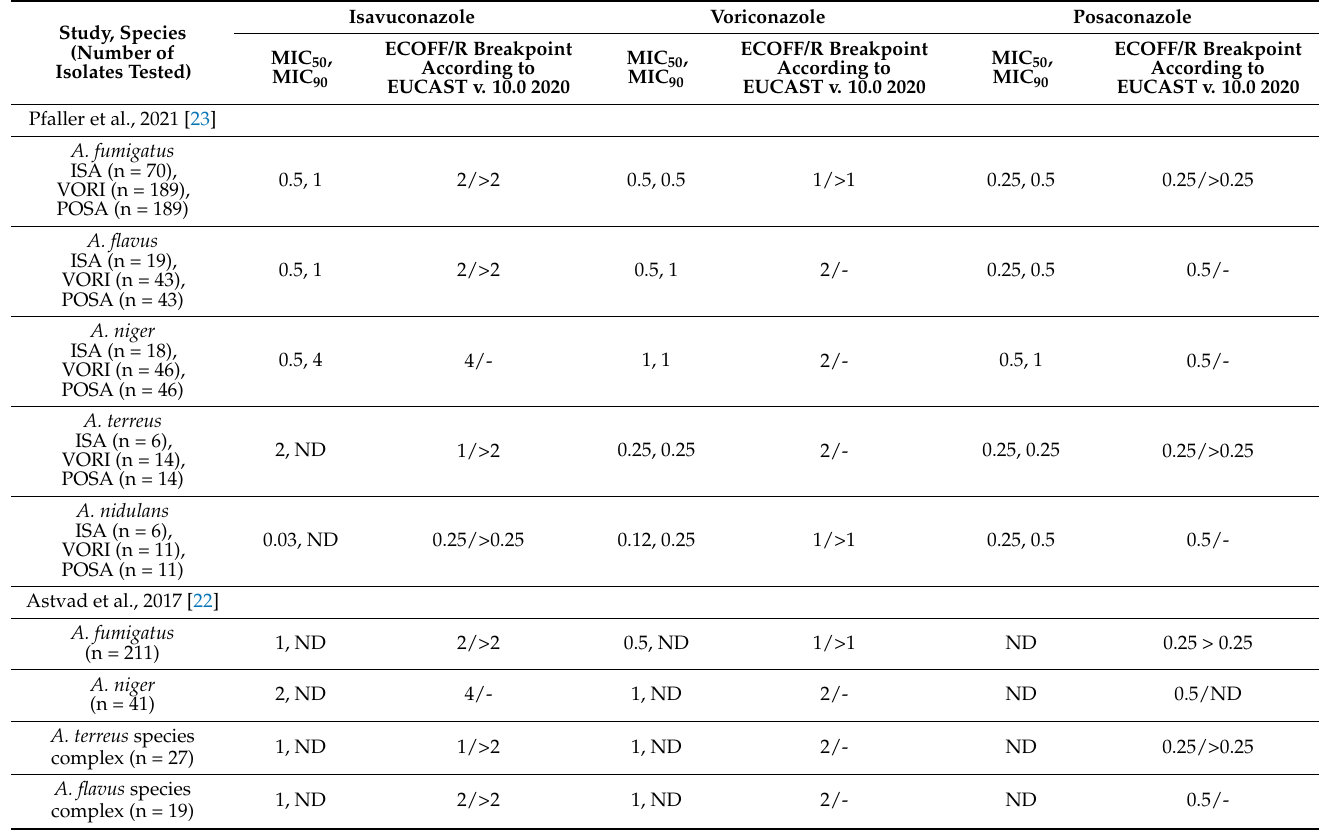
Table 1. MIC 50 , MIC 90 , ECOFF, and breakpoint values (mg/L) for isavuconazole and